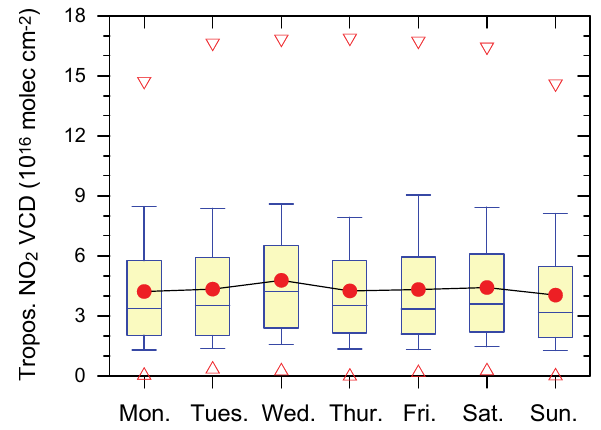
Fig. 8. Weekly cycle of the daily mean tropospheric NO 2 VCD, averaged over the period of August 2008 to September